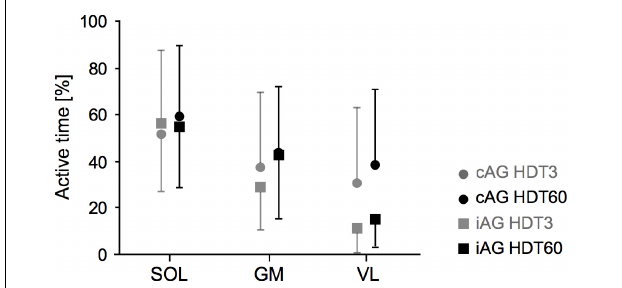
FIGURE 6 | EMG activity during centrifugation. Mean and standard deviation of the active time (percentage spent above baseline EMG activity level) of the three recorded leg muscles (SOL, soleus; GM, gastrocnemius medialis; VL, vastus lateralis) during the two artificial gravity session (HDT3 in gray, HDT60 in black) for the two intervention groups (cAG is represented by circles, iAG by